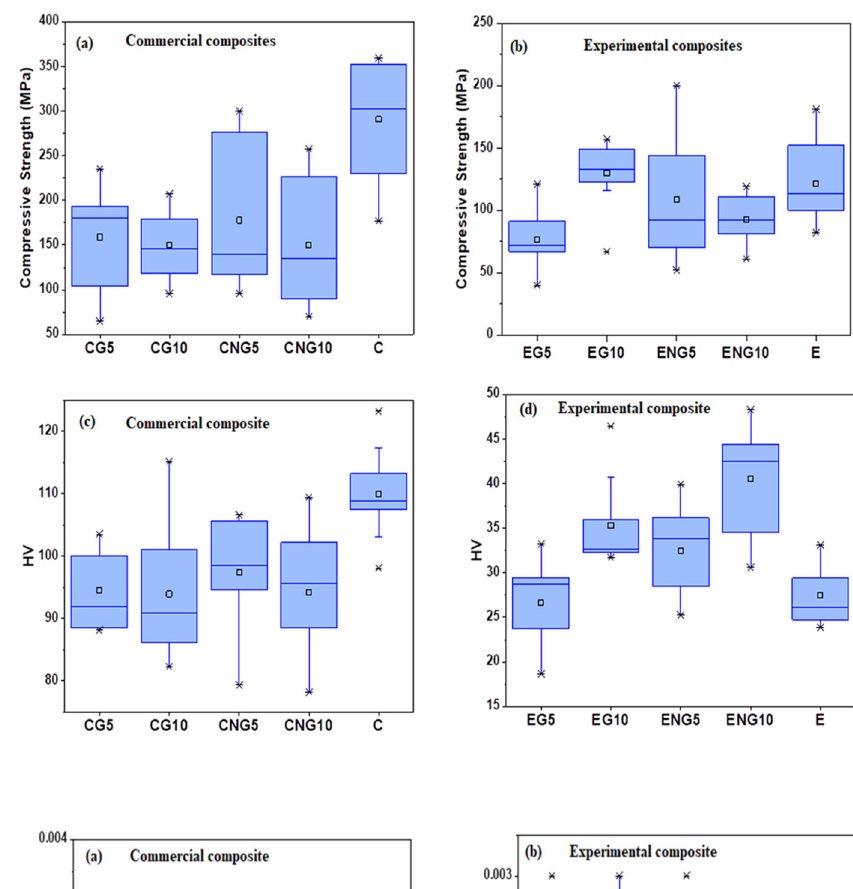
Fig. 5 Mean mass loss and Δ Ra values ( a and c ) Commercial composite groups ( b and d ) Experimental composite groups,